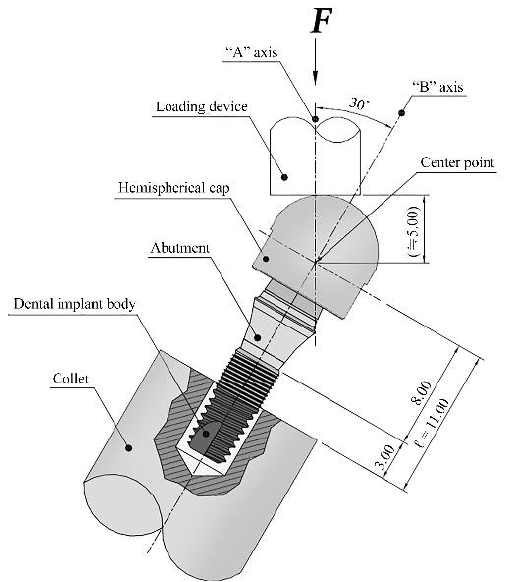
Figure 2. Schematic diagram of the loading test device according to ISO 14801:2013.